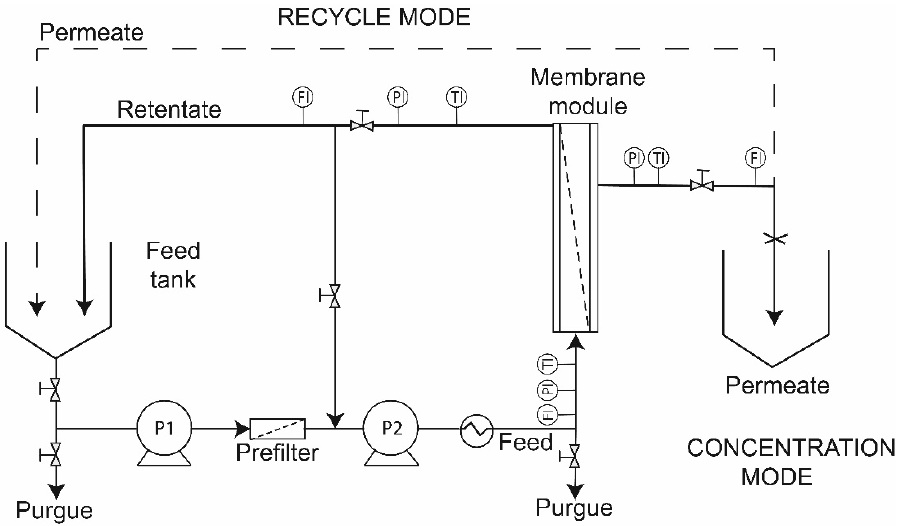
Figure 1. Schematic diagram of the ultrafiltration pilot scale unit used. P1: centrifugal pump; P2: positive displacement pump; TI: Temperature Indicator; PI: Pressure Indicator; FI: Flow Rate Indicator.